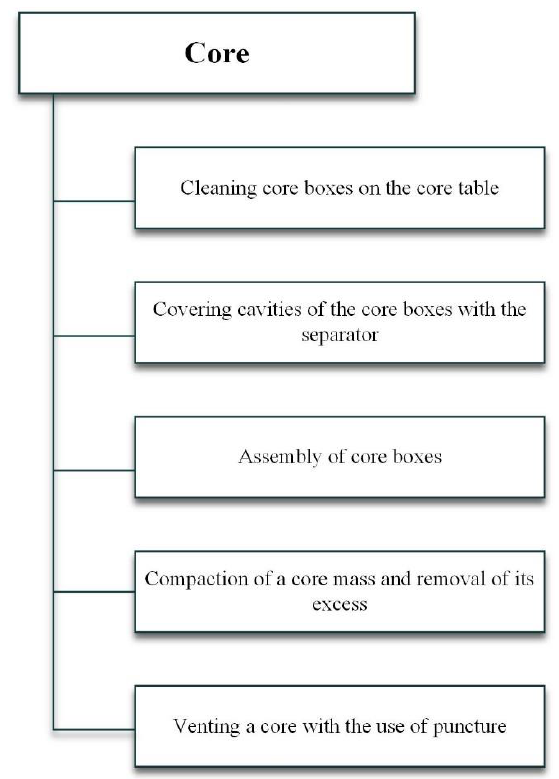
Figure 4. The order of making cores with the use of core boxes.